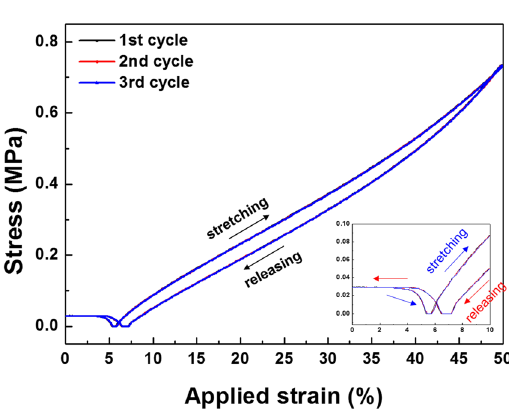
Figure 5. SEM micrographs for encapsulated AgNWs deposited on hydroxylated PDMS: ( a ) the pristine state, ( b ) the 25% strain stretched state, ( c ) the 50% strain stretched state, ( d ) the 75% strain stretched state, and ( e ) the 100% strain stretched state.